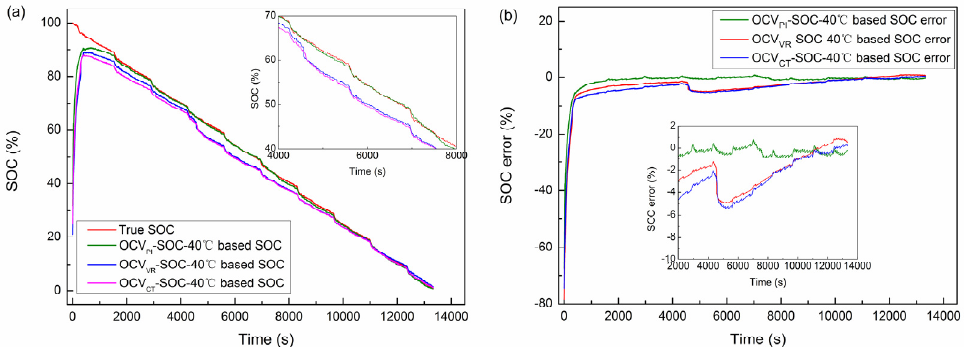
Figure 24. Estimated comparison using the three different OCV–SOC–T relationship maps in the FUDS test at 40 °C: ( a ) SOC and ( b ) SOC error.